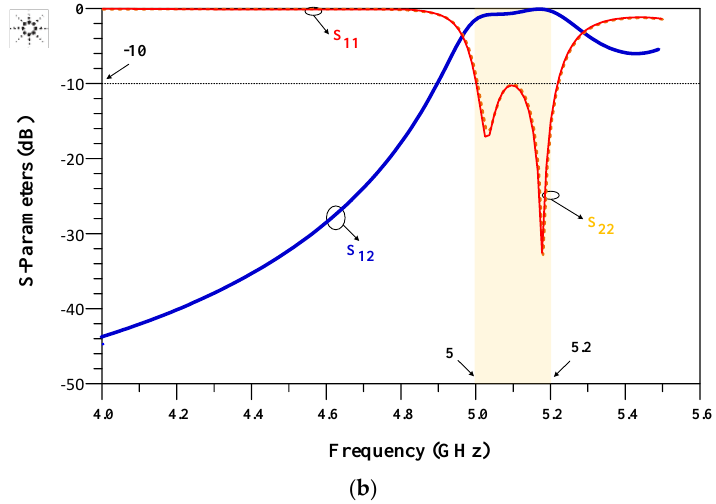
Figure 9. Designed 5.1 GHz filter. ( a ) Circuit structure, and ( b ) S-parameters simulated frequency response (dimensions are in mm).